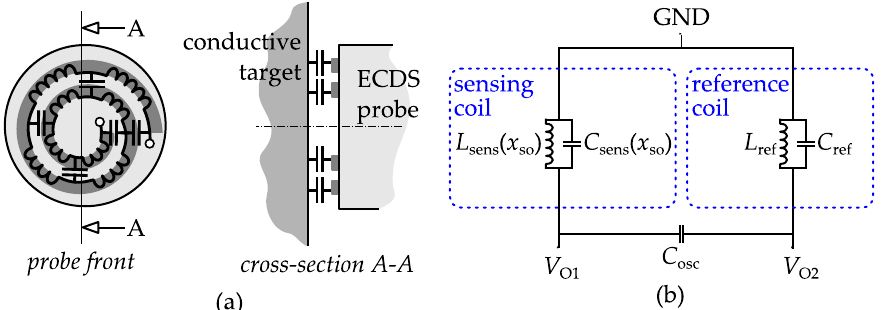
Figure 1. ( a ) Front view and cross-section of an ECDS probe with a flat sensing coil. The coil not only has an inductance that varies with standoff (cid:1876) so , but also has a parasitic interwinding capacitance; ( b ) Schematic of the sensor’s front-end